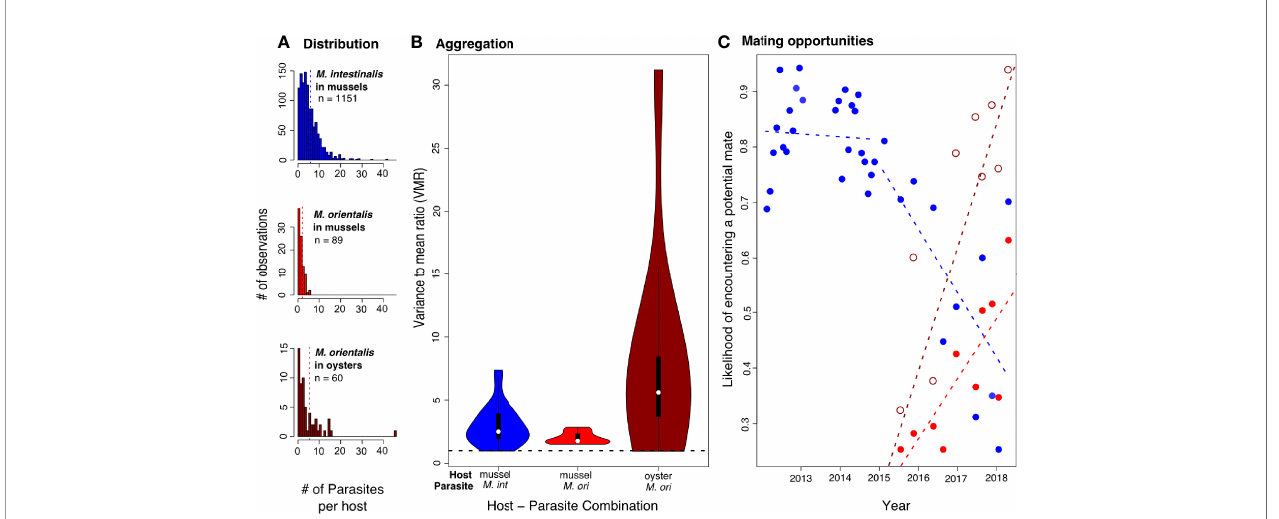
FIGURE 3 | (A) Distribution of number of parasites per host for M. intestinalis (M. int, blue) and M. orientalis (M. ori, red, dark red) over all years of the fi eld survey. Dashed vertical lines show the mean. (B) Aggregation of parasites expressed as the variance to mean ratio (VMR) for all years of the fi eld survey. Variance and means were calculated from infection data of each parasite species found in all hosts dissected at each sampling time point. Violins show the range of the observed data with violin width representing the frequency distribution of values. Box and whiskers give the 50 and 95 percentile, and white dots within boxes show the median. Aggregation was signi fi cantly stronger for M. orientalis in oysters than for M. intestinalis in mussels (estimate = 4.570 ± 1.303, t = 3.507, p < 0.001) but did not differ between the parasite species when infecting mussels (estimate = -0.880 ± 1.303, t = -0.675, p = 0.502). (C) Likelihood of encountering a mate in an infected host on a given sampling event assuming the simplest case of a 1:1 sex ratio. In years without (2012-2016) Mytilicola orientalis mating opportunities for Mytilicola intestinalis (blue dots) showed no signi fi cant trend (R 2 = 0.005, estimate = -0.000 ± 0.001, t = -0.34, p = 0.737). However, after the appearance of M. orientalis in 2016 a signi fi cant decline over the sampling period was observed (R 2 = 0.421, estimate = -0.010 ± 0.004, t = -2.559, p = 0.031), while M. orientalis ’ chances of encountering a potential mate in a given host increased in both hosts (mussel: R 2 = 0.576, estimate